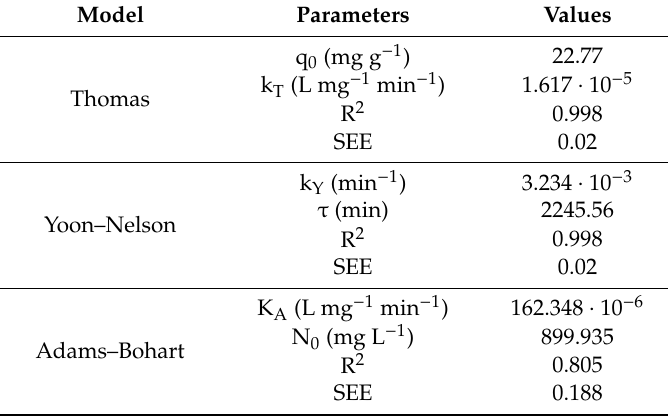
Table 4. Breakthrough curve models’ parameters for the [bpy] Cl-S-Fe system. Operational